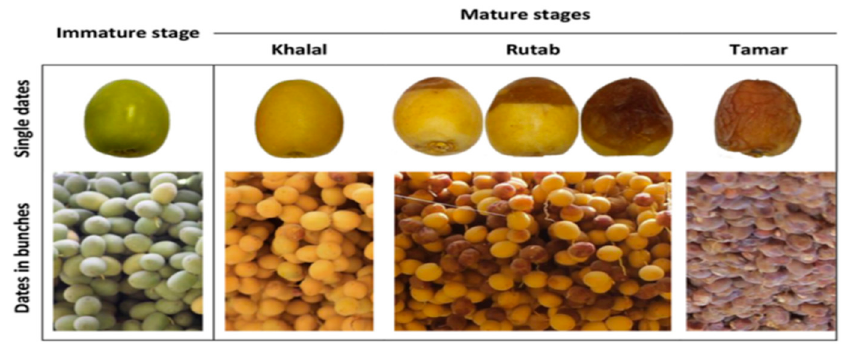
Figure 1. Immature stages for Al-barhi Date fruit in three mature stages (Khalal, Rutab, and Tamar). Adopted from [2].